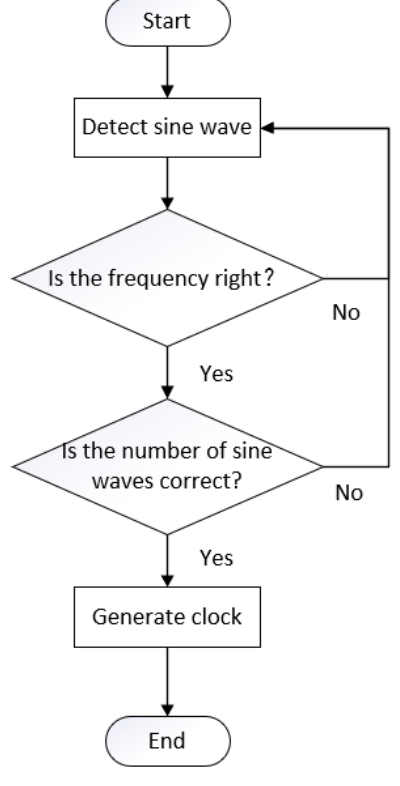
Figure 4. Synchronous clock generation.